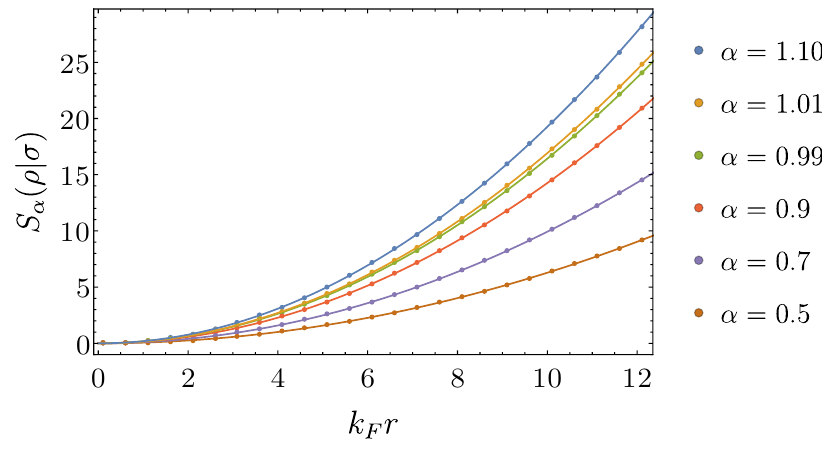
Figure 9 . Plot of S α with α ∈ [0 . 5 , 1 . 1] for m = 0 , comparing states with k F = 0 and k F = 1 / 20 . A functional dependence S α = A α ( k F r ) 2 is observed and plotted for all α considered. When α → 1 the plots create a bound from above and from below to the relative entropy. The coefficients of the fits are approximately A α = 0 . 164 for α = 0 . 99 and A α = 0 . 169 for α = 1 . 01 ; this agrees with the analytic prediction A 1 = 1 / 6 for α = 1 in (6.7).